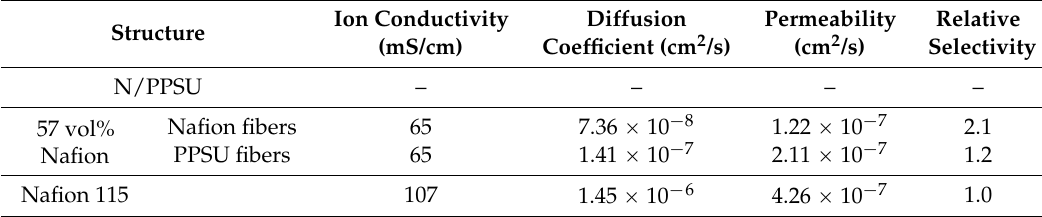
Table 2. Transport properties of the two nanofiber composite membrane structures, with the same Nafion content. The measured properties of a Nafion 115 reference film are also listed.